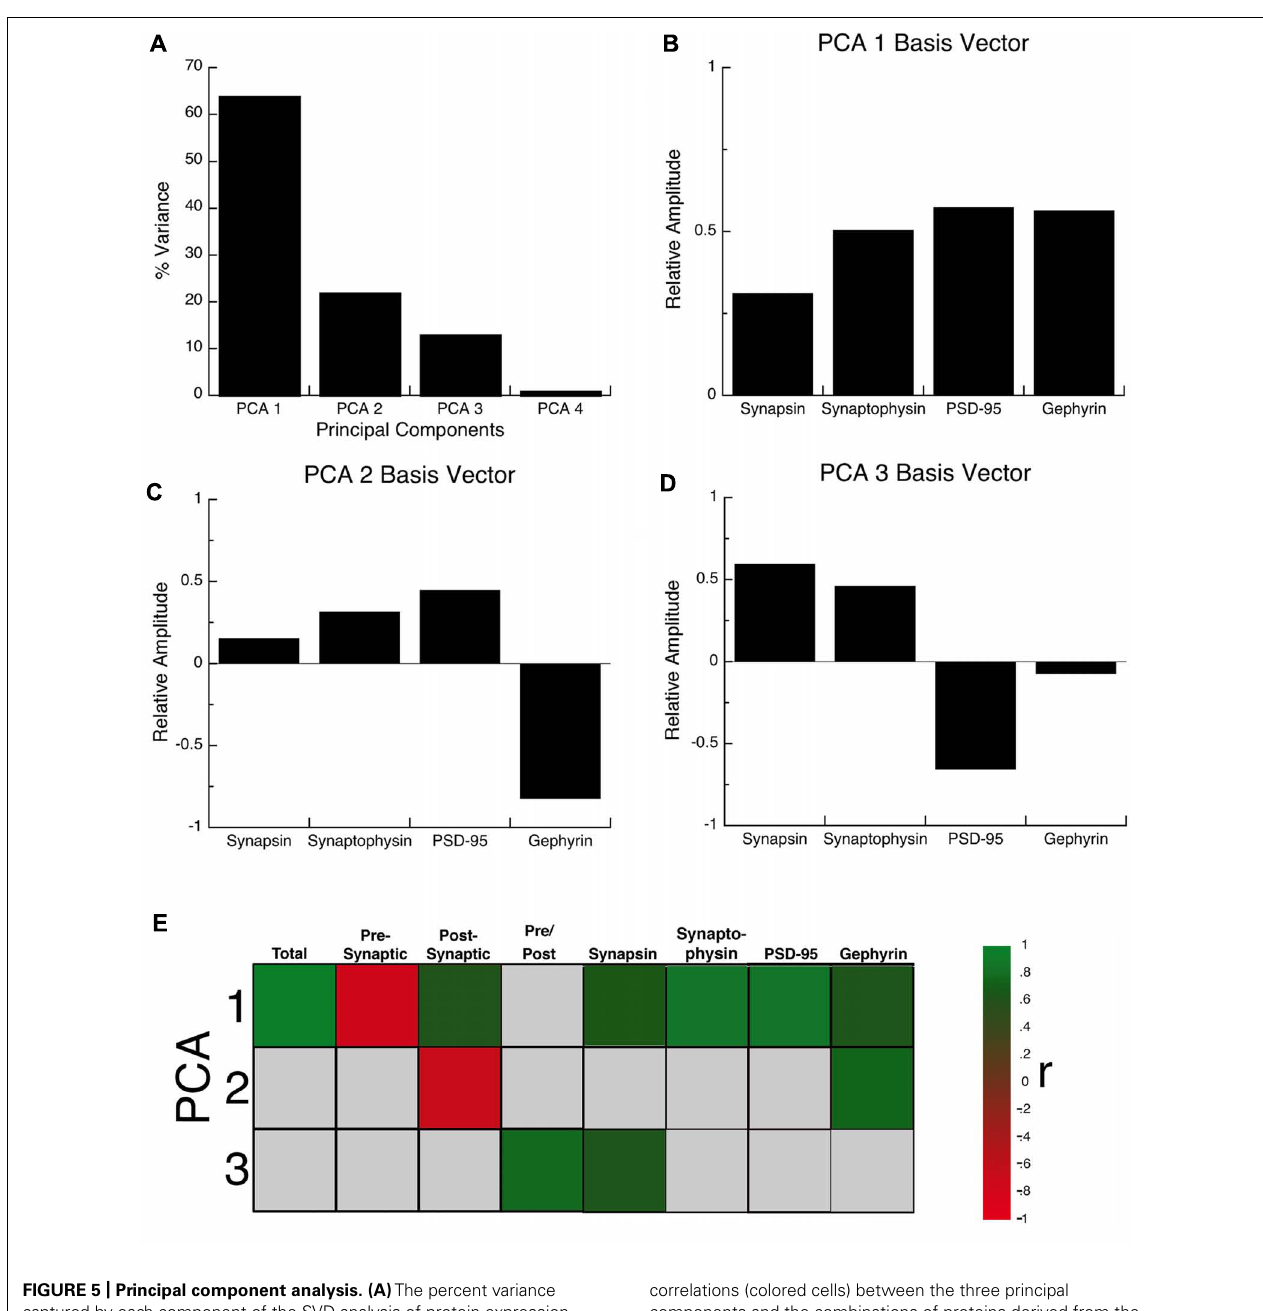
correlations (colored cells) between the three principal components and the combinations of proteins derived from the basis vectors.The color indicates the magnitude (represented by color intensity) and direction (green indicates positive, red indicates negative) of significant correlations (Bonferroni corrected, p <